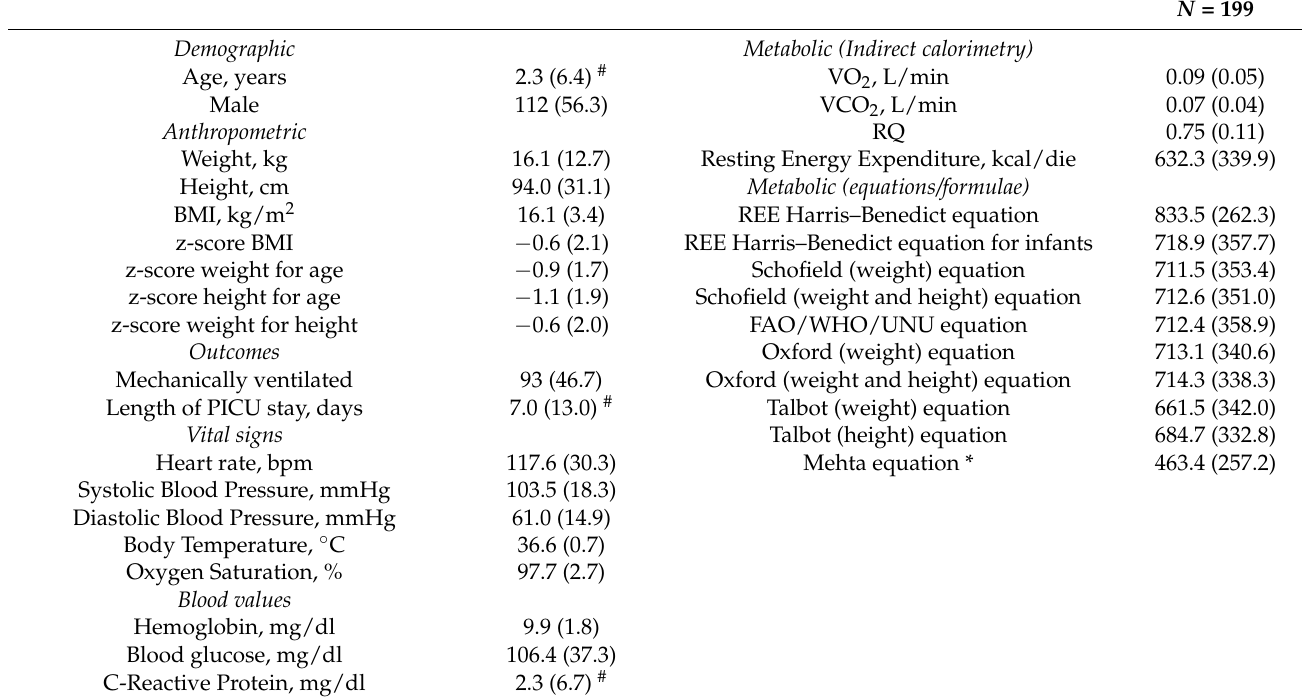
Table 4. Anthropometric, functional, and metabolic measurements of the study population.